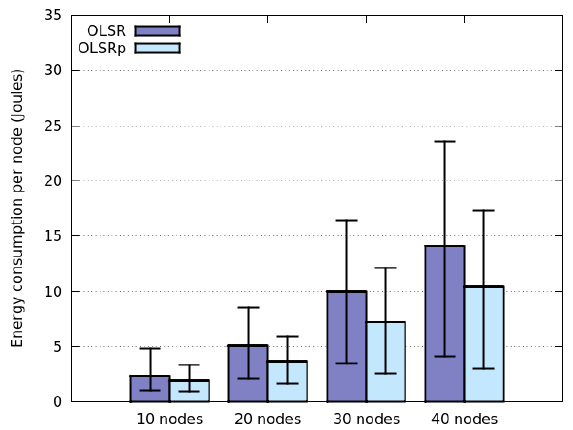
Figure 5. Energy consumption when nodes follow a SLAW